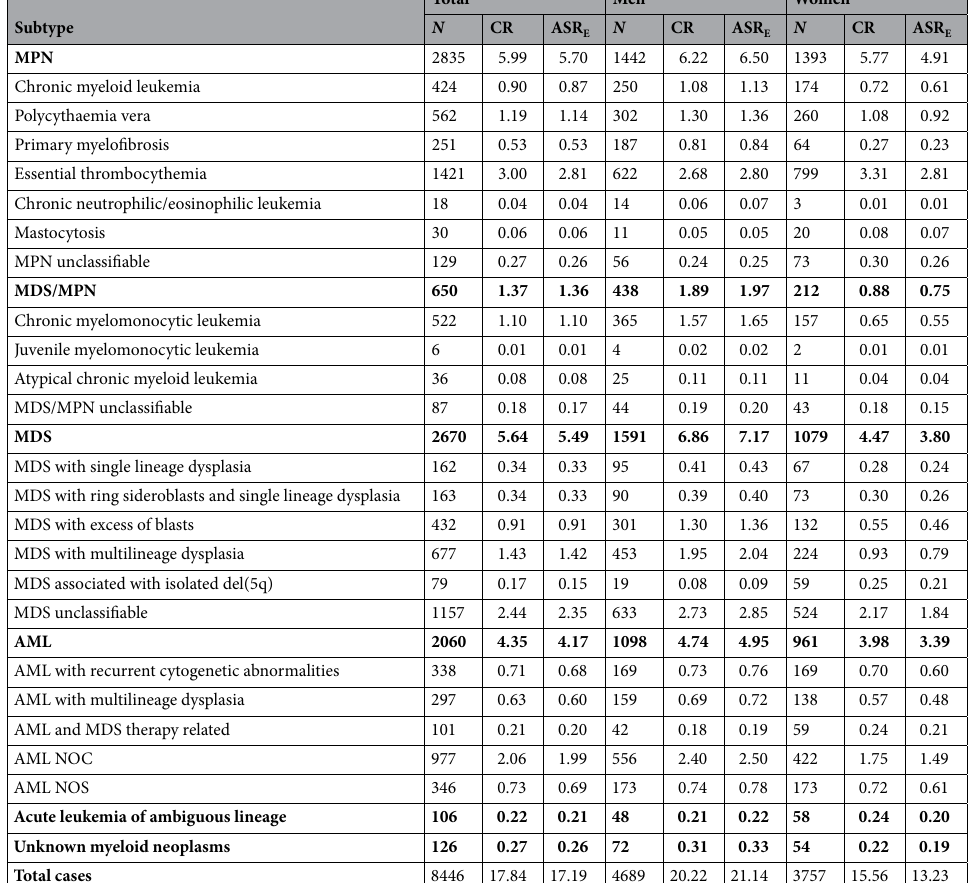
neoplasms, MDS myelodysplastic syndromes, MN myeloid neoplasms, NOC not-otherwise categorized, NOS not-otherwise specified. Rates are expressed in 100,000